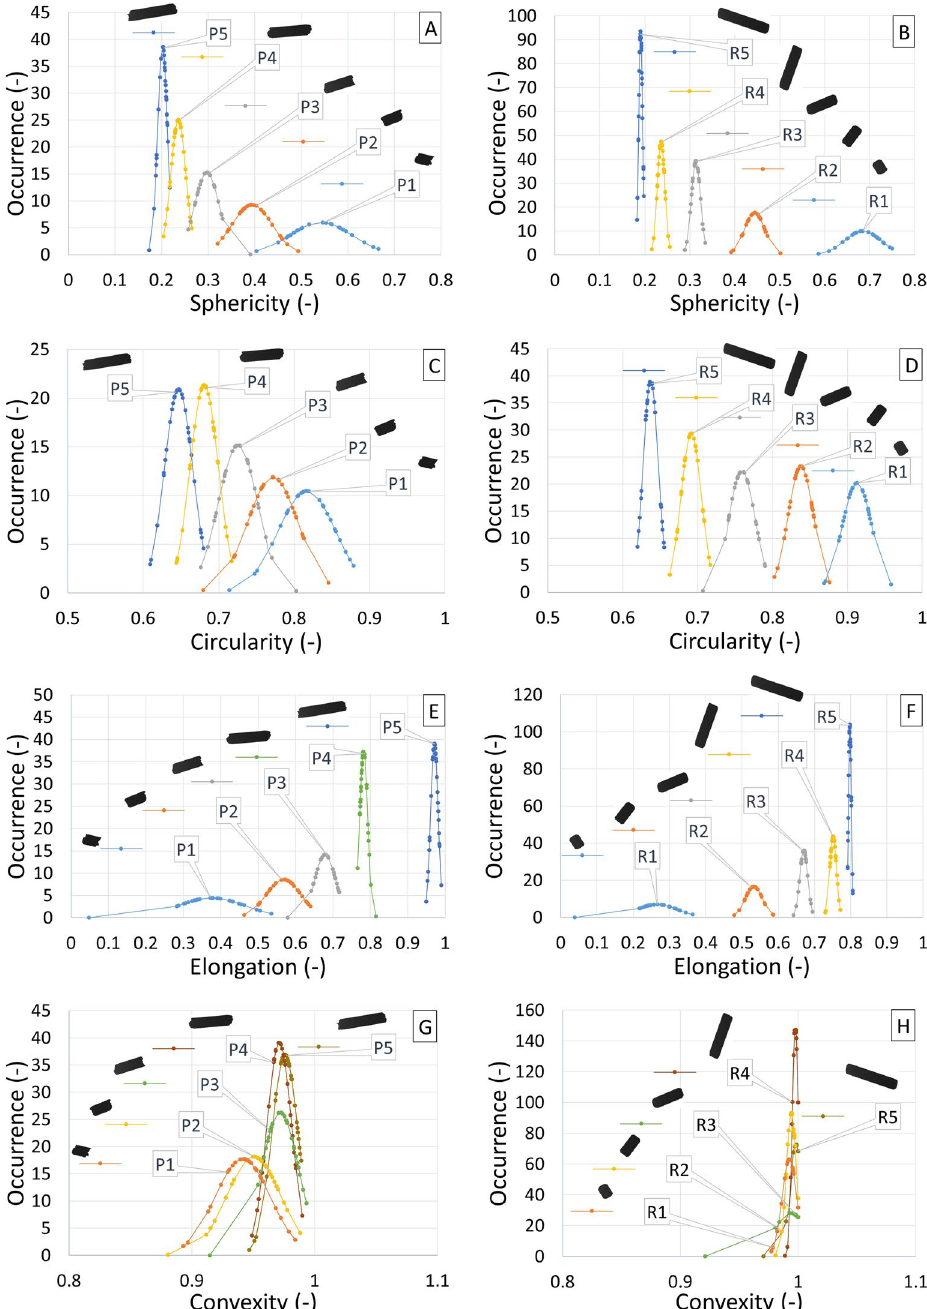
Figure 11. Particle shape—sphericity, circularity, elongation, convexity of sorted pellets and